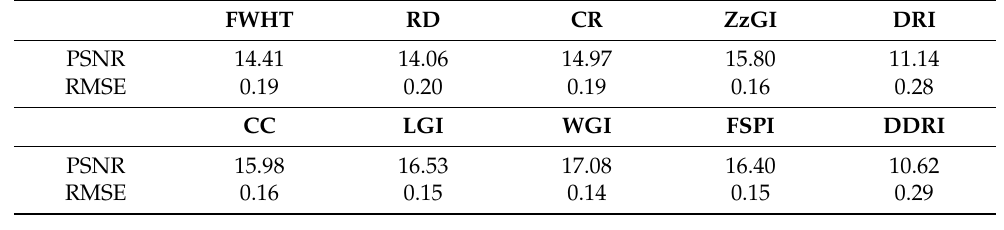
Figure 11. ( a ) UGI image restored by LGI, and ( b ) side wall image of the WT. The red dotted cir- cles in ( a , b ) denote the possible relationship between the dirt stains and light spots.